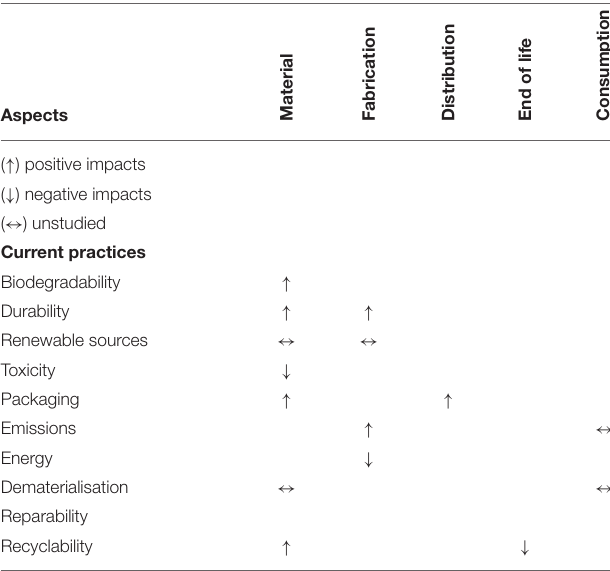
TABLE 1 | Environmental impacts of makerspaces, adapted from Kohtala and Sampsa (2015).